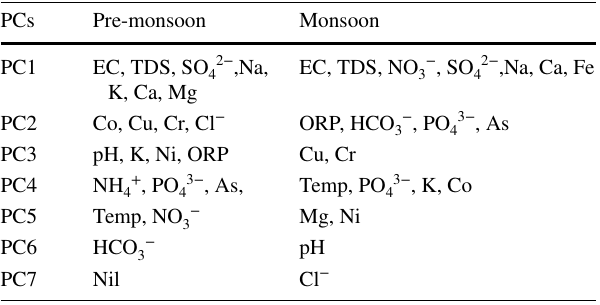
Table 7 Comparison of principal components during the pre-mon- soon and monsoon